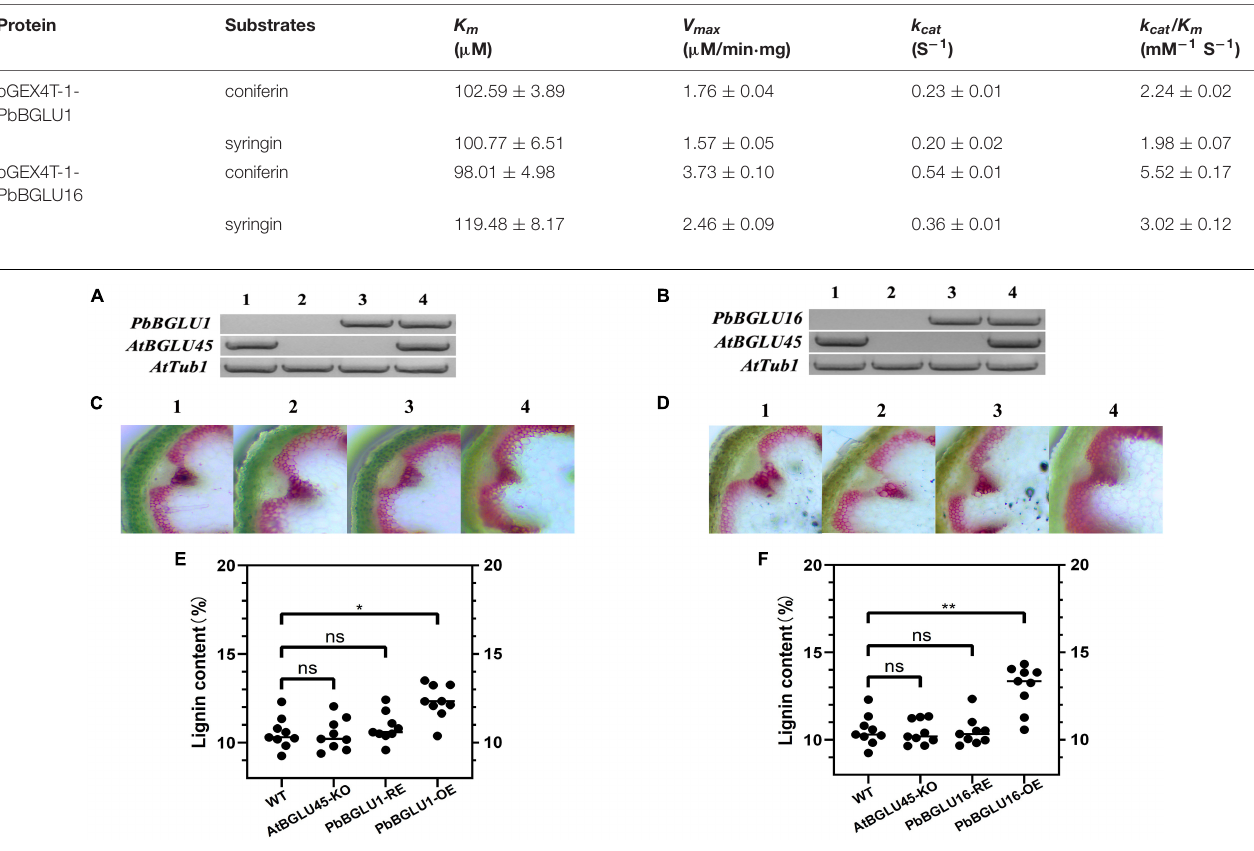
TABLE 1 | Enzyme kinetics of PbBGLU1 and PbBGLU16. Protein